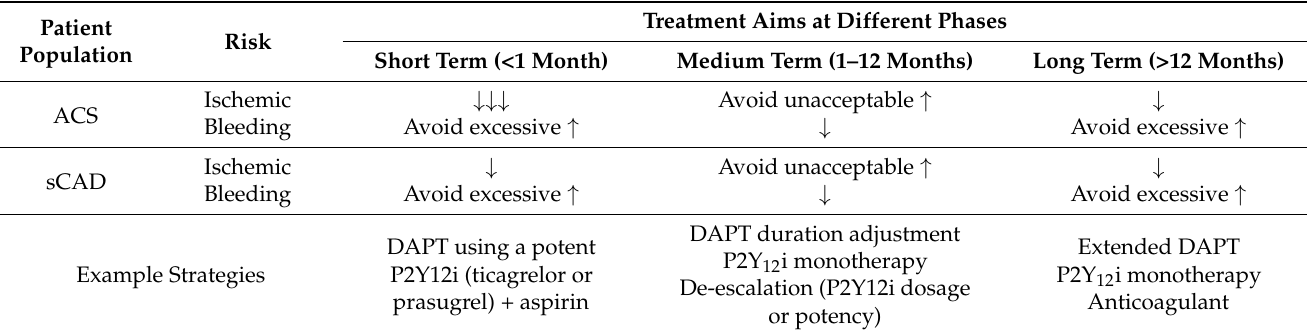
Table 1. Treatment aims and strategies of antiplatelet therapy at various